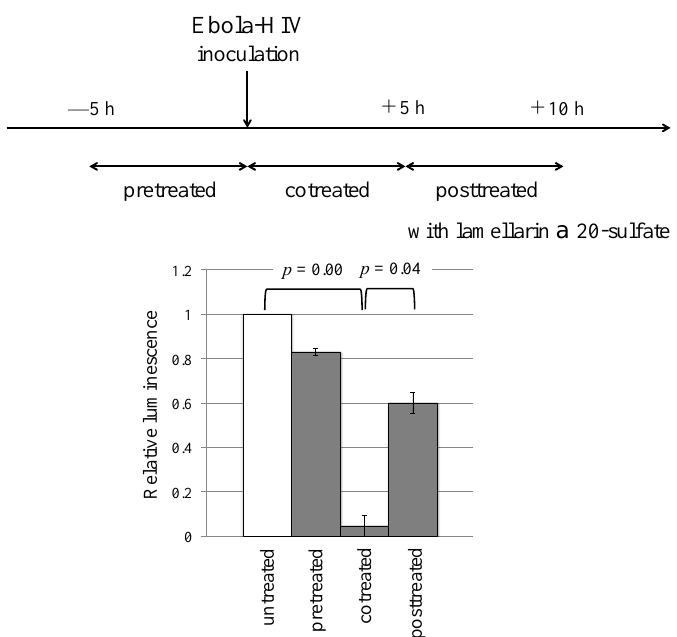
Figure 3. Effects of time at which lamellarin α 20-sulfate was added on inhibitory effects. The 293T cells were treated with lamellarin α 20-sulfate (150 µ M) at the time points indicated in the upper panel, as indicated in the Materials and Methods section. The luciferase activities of DMSO-treated cells were always set to 1, and the relative values to the luciferase activities of the DMSO-treated cells are indicated. This experiment was repeated three times. Error bars indicate SD. When the differences between indicated groups are significant, the p values of Student’s t -test are